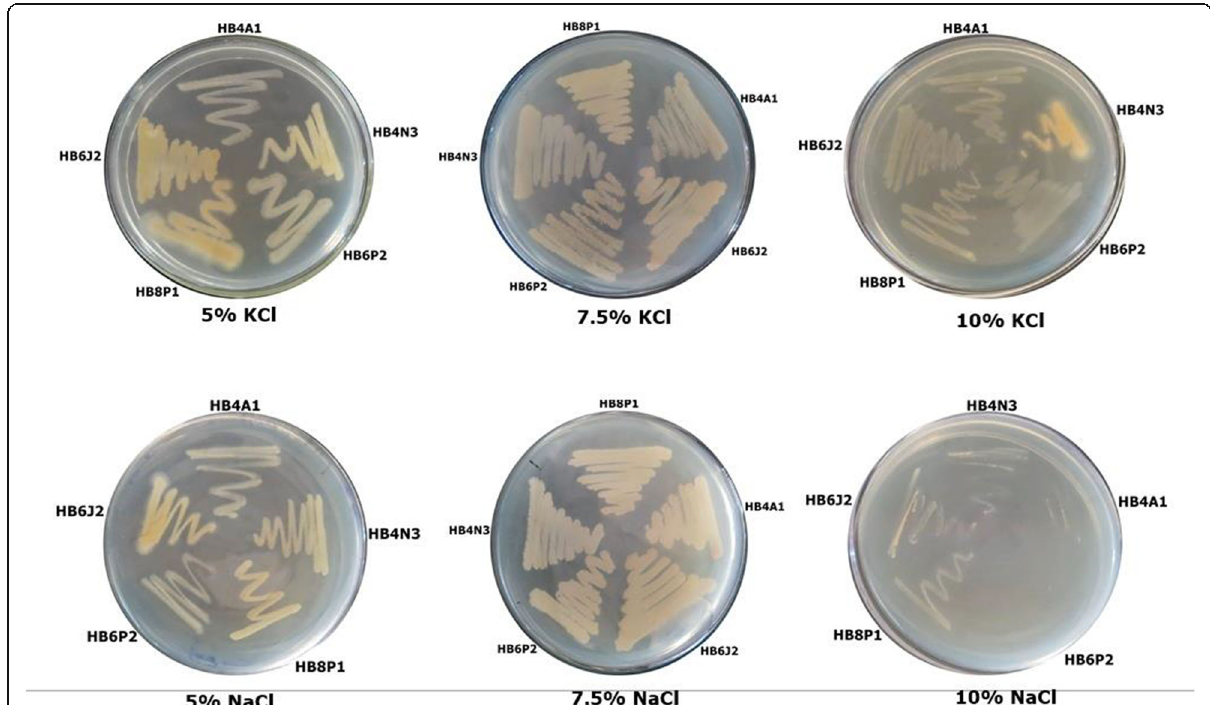
Fig. 2 Growth of bacterial isolates HB6J2, HB8P1, HB4A1, HB4N3 and Hb6P2 on media containing 5%, 7.5% and 10% KCl, and NaCl, respectively